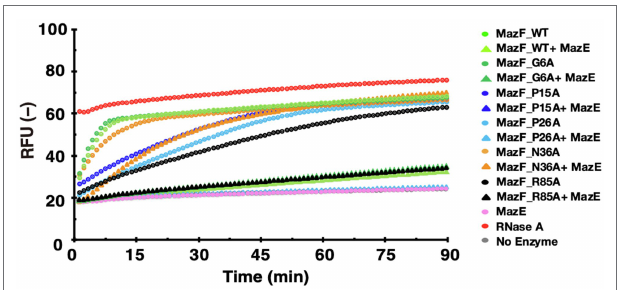
FIGURE 7 | Neutralization of the activity of MazF-Da mutants by MazE-Da. The activity of MazF-Da or MazF-Da mutants against the UACAAA probe and the inhibition of activity by MazE-Da were measured. The fluorescence intensity was continuously measured. Circles indicate the MazF-Da or the MazF-Da mutant alone, and triangles indicate the MazF-Da or the Maz-Da mutant and the MazE-Da